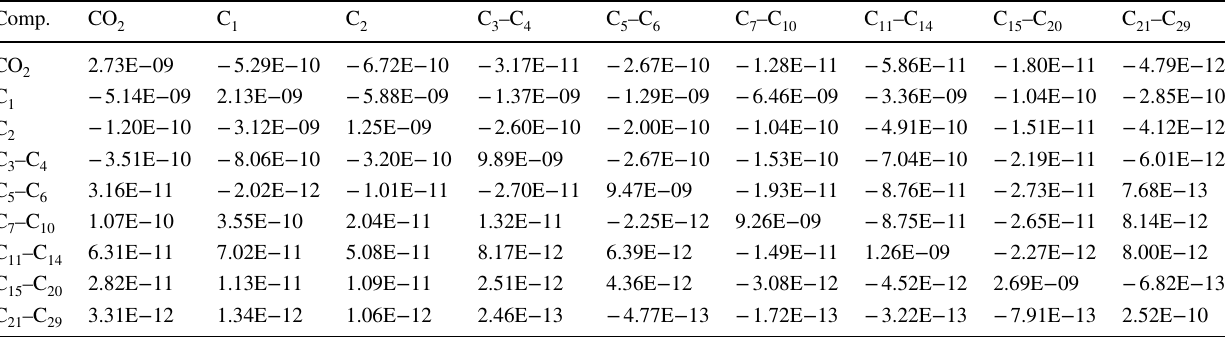
Table 5 Molecular diffusion coefficient estimations, based on Kooijman–Taylor correlations (m 2 /s) Comp.